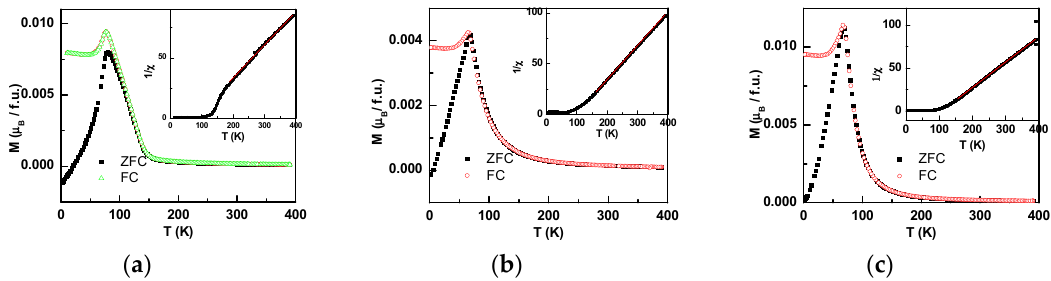
Figure 2. The magnetization versus the temperature of Ir 0.9 Mn 1.05 Sn 1.05 ( a ), Ir 0.9 Mn 0.95 Sn 1.15 ( b ), and Ir 0.9 Mn 0.9 Sn 1.2 ( c ), and the inset is the corresponding inverse susceptibility versus the temperature with the red line as the fitting curve to the Curie-Weiss law.